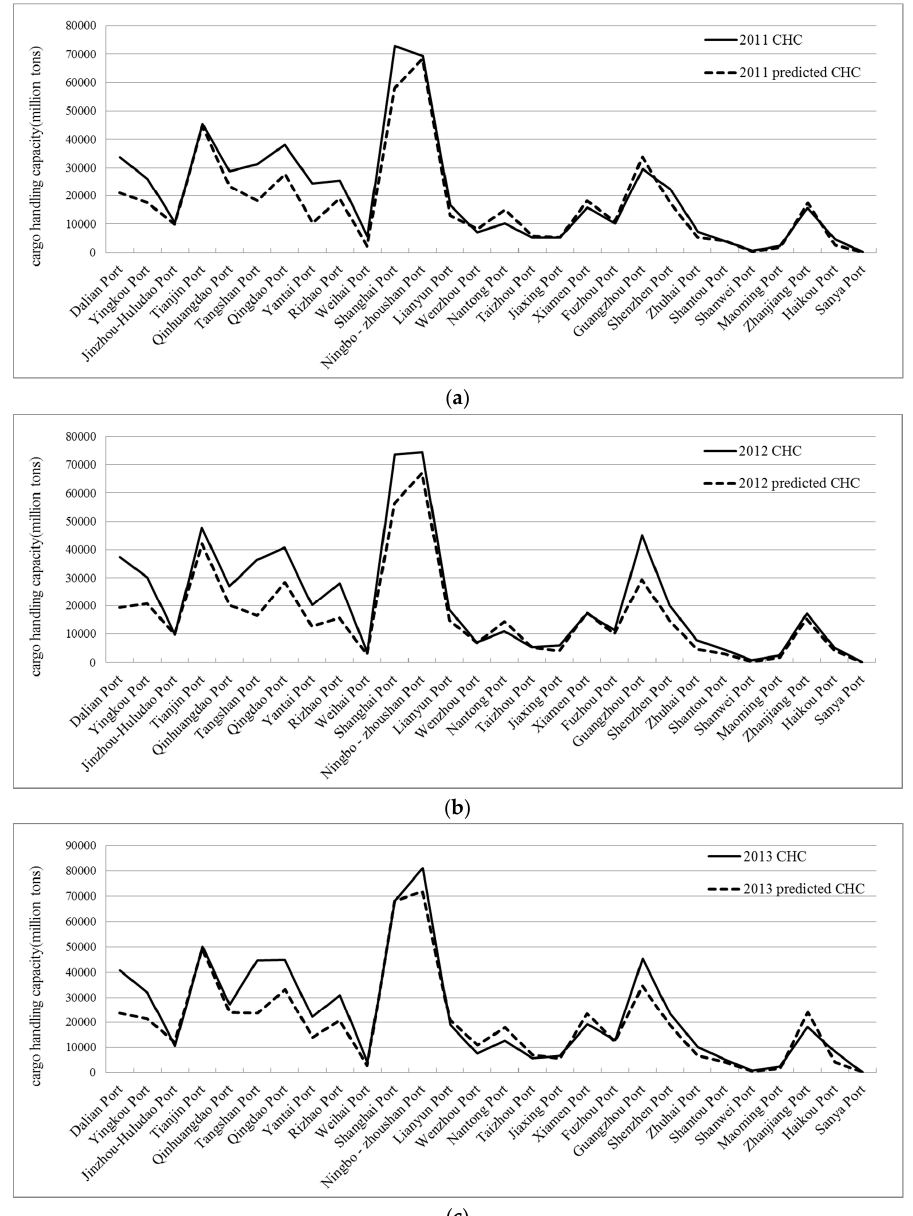
Figure 6. Comparison between the real and predicted CHC of coastal ports: for the year of 2011, 2012, and 2013: ( a ) Comparison between real and predicted CHC of coastal ports in 2011; ( b ) Comparison between real and predicted CHC of coastal ports in 2012; ( c ) Comparison between real and predicted CHC of coastal ports in